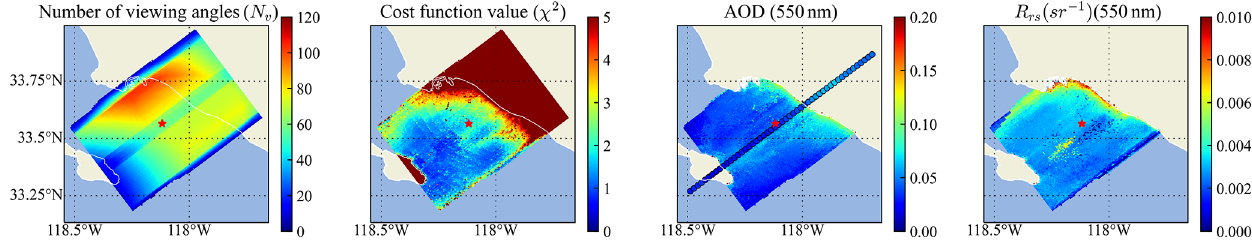
Figure 17. Same as Fig. 15 but for Scene 3. The pixels with large χ 2 are mostly influenced by the land (upper region) and island (lower left). The retrieved AOD and R rs over land pixels are not shown. The location of the AERONET USC_SEAPRISM site is indicated by a red star symbol.